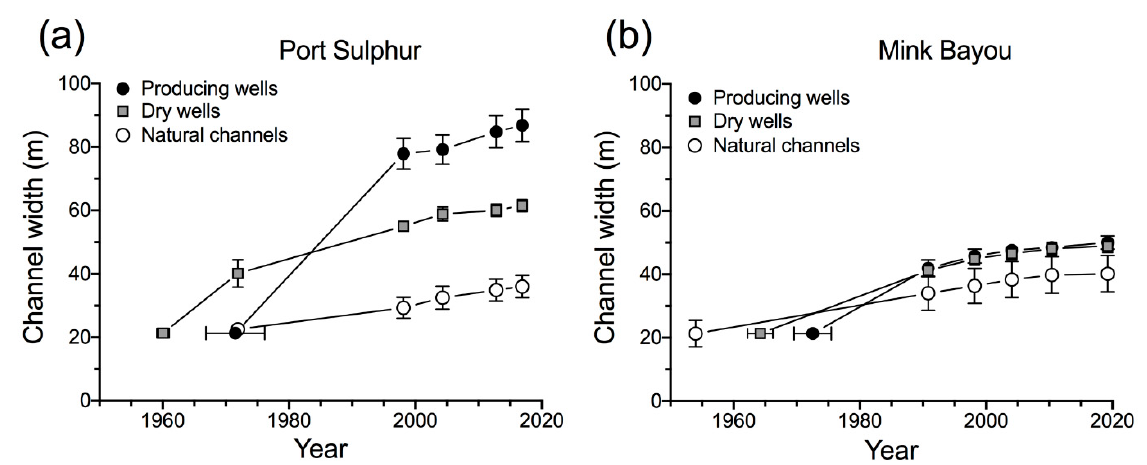
Figure 3. The average width (m) of the three waterways at two locations ( µ ± 1 SEM). The horizontal bars depict the age ( µ ± 1 SEM) of the canal; ( a ) Port Sulphur; ( b ) Mink Bayou.